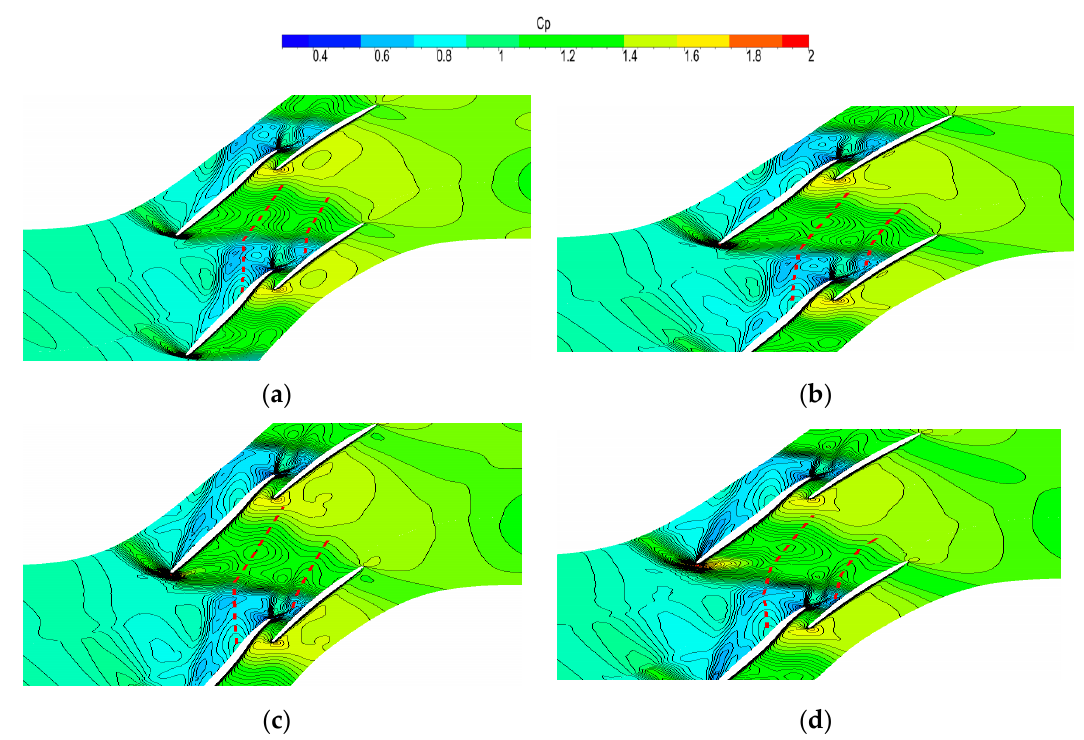
Figure 21. Comparison of the static pressure coefficient diagram near the casing end wall of PB10, PB20, and PB30. ( a ) ORG. ( b ) PB10. ( c ) PB20. ( d ) PB30.